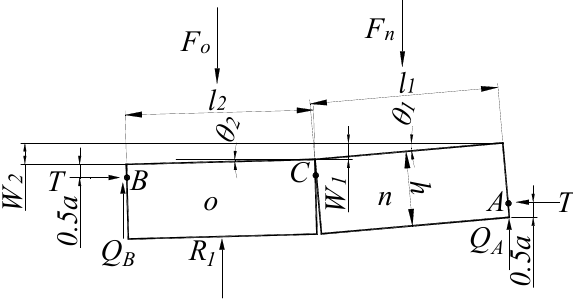
Figure 8. The mechanical model of rock blocks n and o .